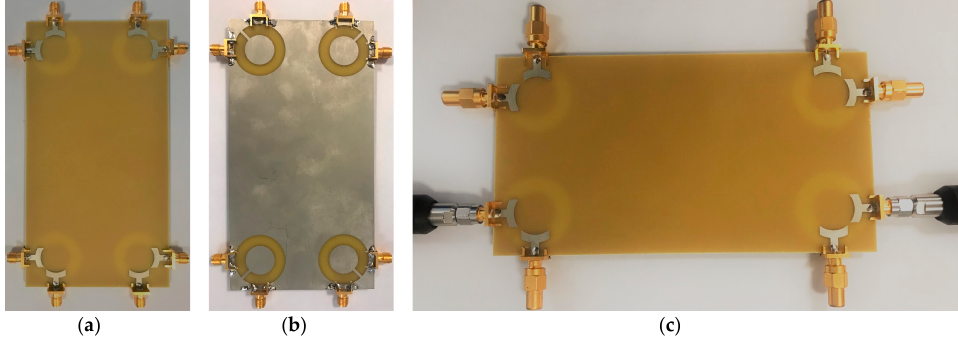
Figure 20. Fabricated prototype, ( a ) top view, ( b ) bottom view, and ( c ) feeding mechanism.